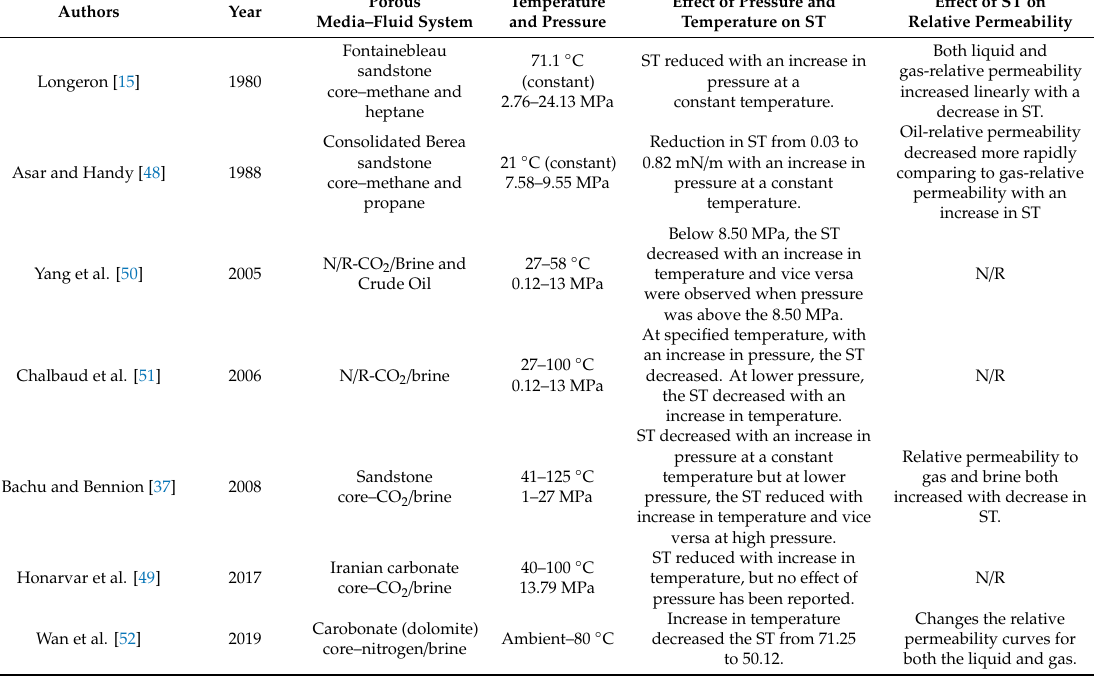
Table 2. Summary of the e ff ect of surface tension (ST) on liquid / gas-relative permeability reported in reviewed